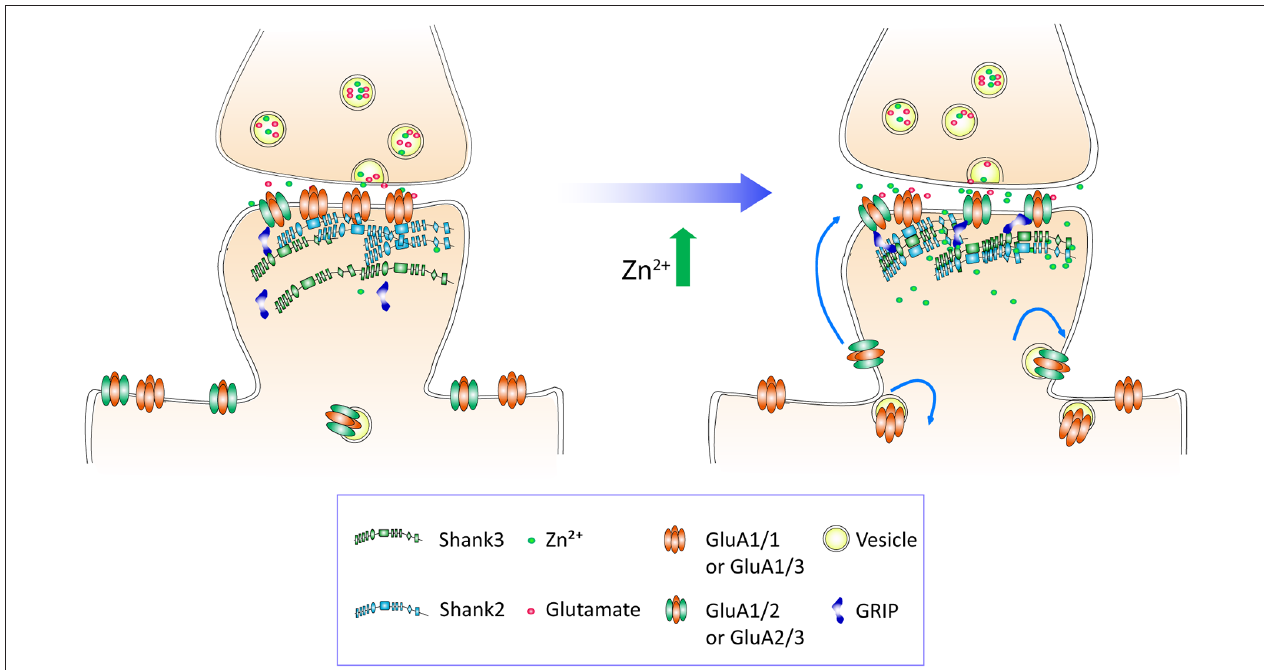
FIGURE 12 | A model for Shank mediation of zinc-dependent subunit switch of AMPAR in developing synapses. A glutamatergic synapse of a wild-type (WT) young neuron is shown with low levels of Shank3 (green) and GluA2 (teal) and high levels of Shank2 (blue) and GluA1 (orange). The synaptic complement changes with zinc-sensitive recruitment of synaptic GluA2 via exocytosis and lateral diffusion (blue arrows), leading to potentiation of AMPAR-mediated synaptic activity. The zinc-recruitment of GluA2 correlated with the level of synaptic Shank3. Zinc addition also led to reduction of synaptic GluA1, which is most likely driven by Shank2. Hence, loss of either Shank2 or Shank3 abolished the zinc-sensitive potentiation of AMPAR-mediated synaptic transmission.